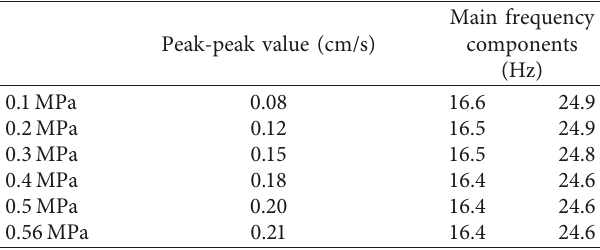
Table 4: Peak-peak value and main frequency components of MP4 under different